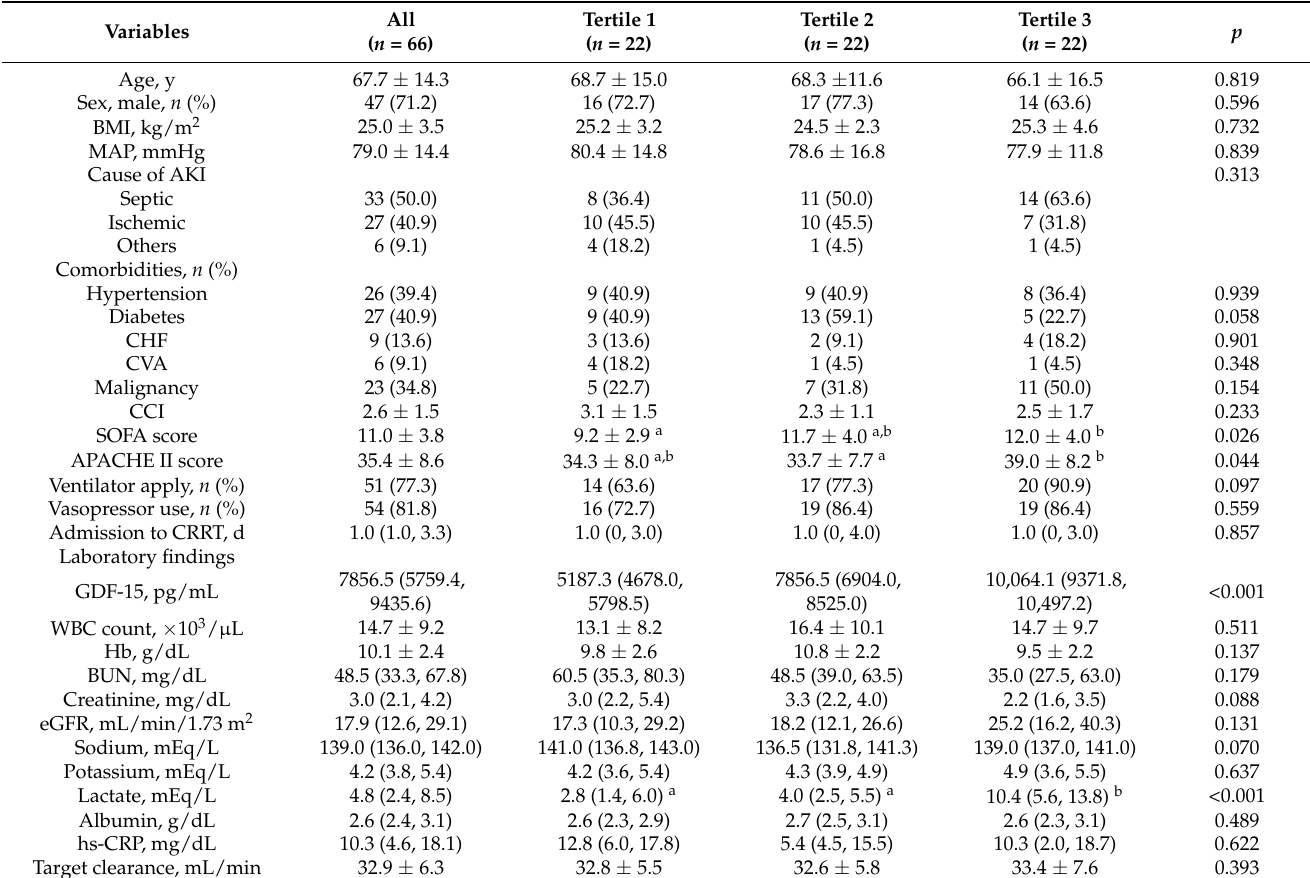
Table 1. Baseline characteristics at the time of continuous renal replacement therapy (CRRT)